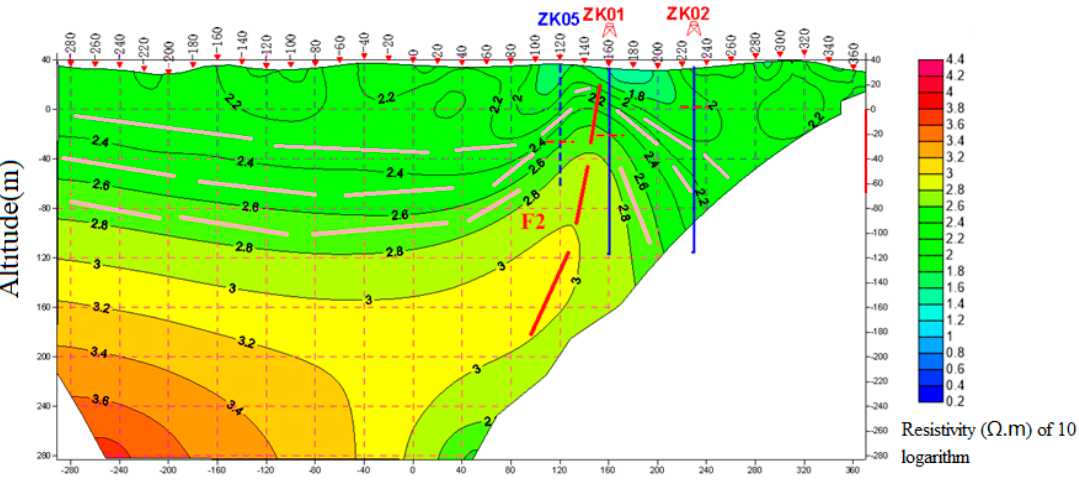
Figure 10. The pseudo − 3D resistivity inversion results of the L2 survey line. The value of the median line in the figure is the base 10 logarithm of the resistivity (the red lines represent the fault. The pink lines in the segment layer represent the resistivity. The blue lines indicate the locations of boreholes).